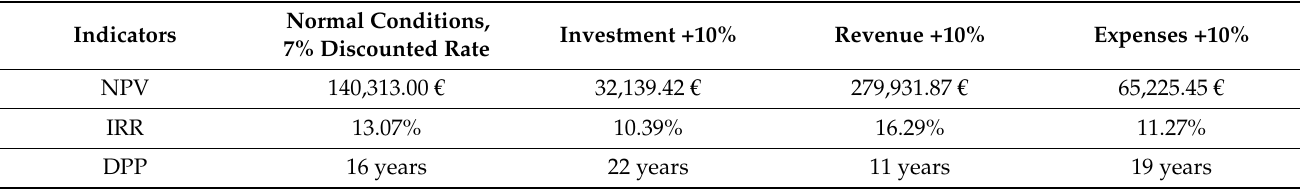
Table 8. Financial indicators for the location